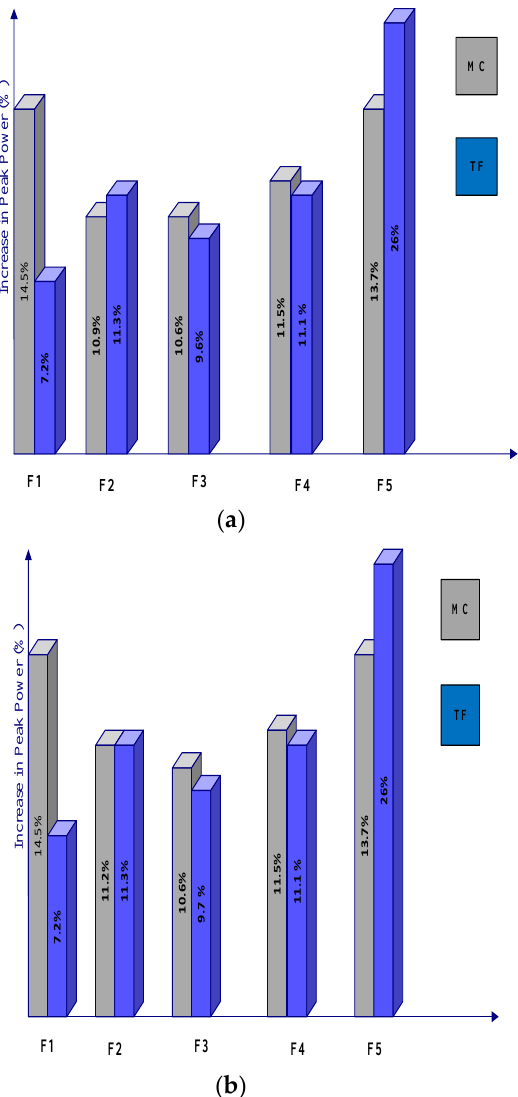
Figure 9. FL and PSO schemes under all fault scenarios: ( a ) Comparison of increase in peak power from monocrystalline and thin film PV arrays with implementation of the proposed FL-based scheme under the studied fault cases. ( b ) Comparison of increase in peak power from monocrystalline and thin film PV arrays with implementation of the proposed PSO-based scheme under the studied fault cases.